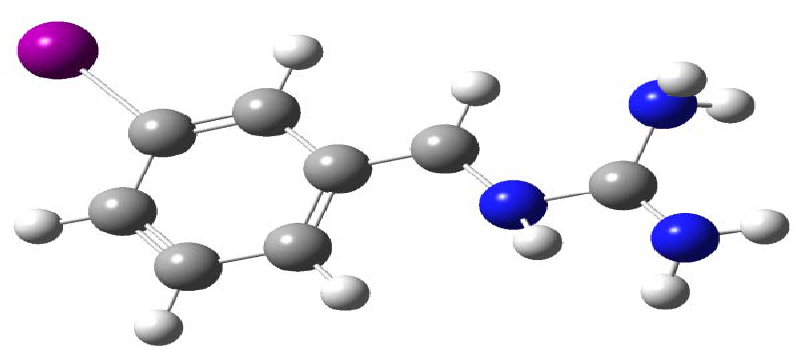
Fig.1: Geometrically optimized of structure of